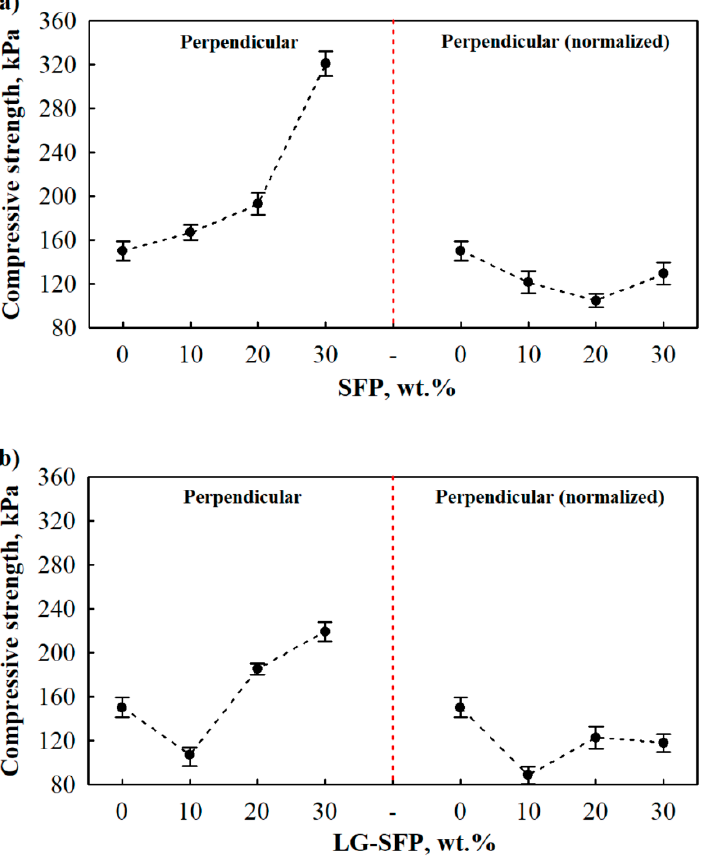
Figure 6. Compressive strength of SFP and LG-SFP modified PUR foams: ( a ) SFP modified PUR foam perpendicularly to foaming direction; ( b ) LG-SFP modified PUR foam perpendicularly to foaming direction.